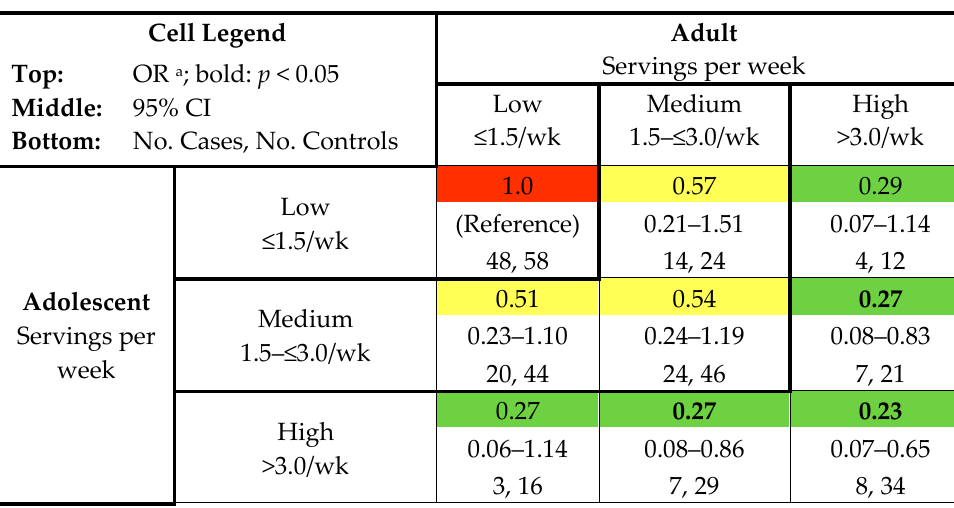
Table 4. Breast cancer risk in Polish-born women residing in Cook County, IL or the Detroit Metropoli- tan Area, MI: Adjusted ORs for joint levels of consumption of raw/short-cooked cabbage/sauerkraut products during adolescence and adulthood.